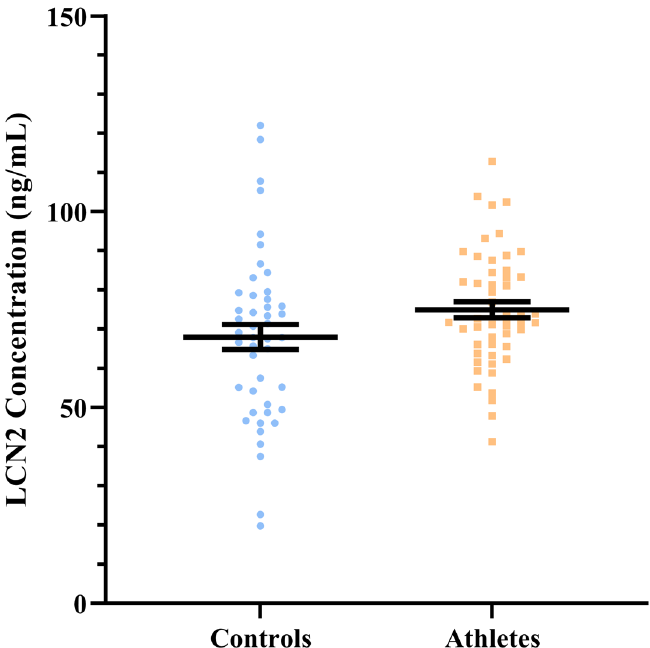
Figure 1. There was no difference in plasma lipocalin-2 (LCN2) protein levels between controls (n = 48) and endurance athletes (n = 52) ( P = 0.073). Data are expressed as mean ± S.E.M. from two-tailed Man-Whitney U-test.